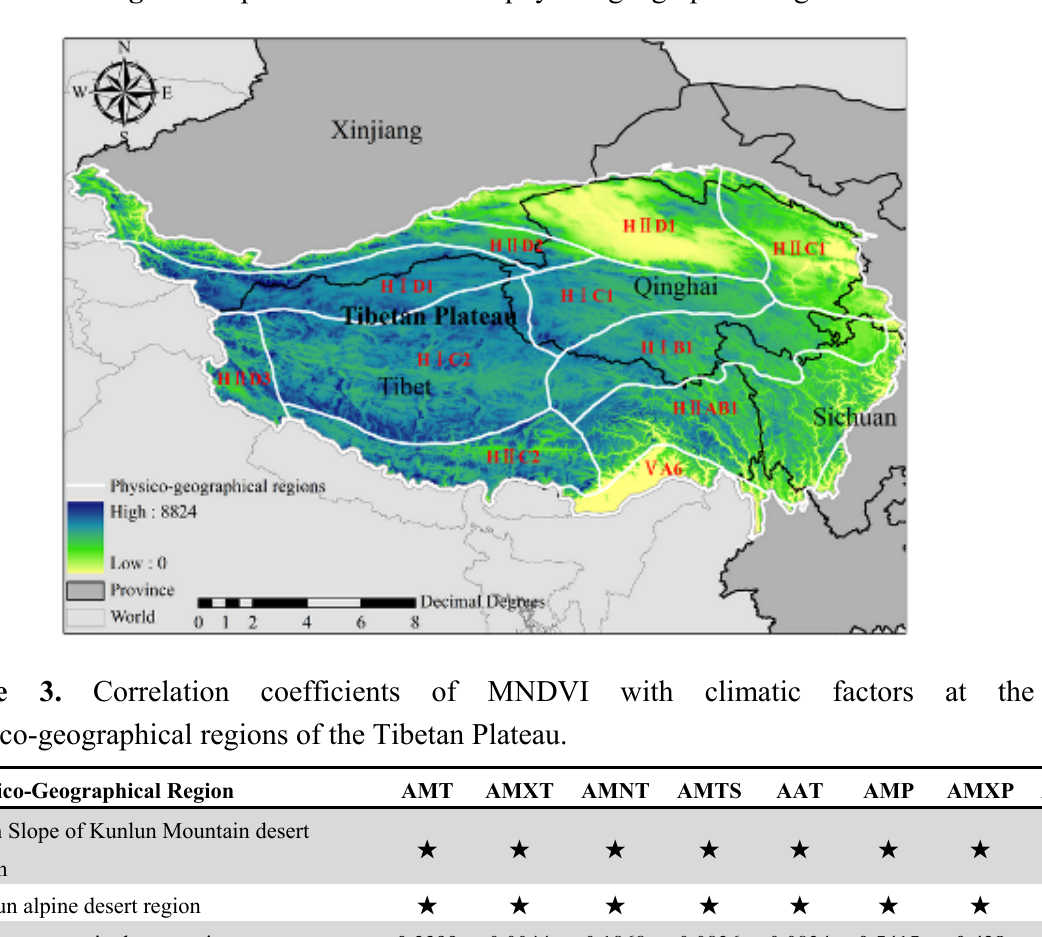
Figure 6. Spatial distributions of physico-geographical regions.